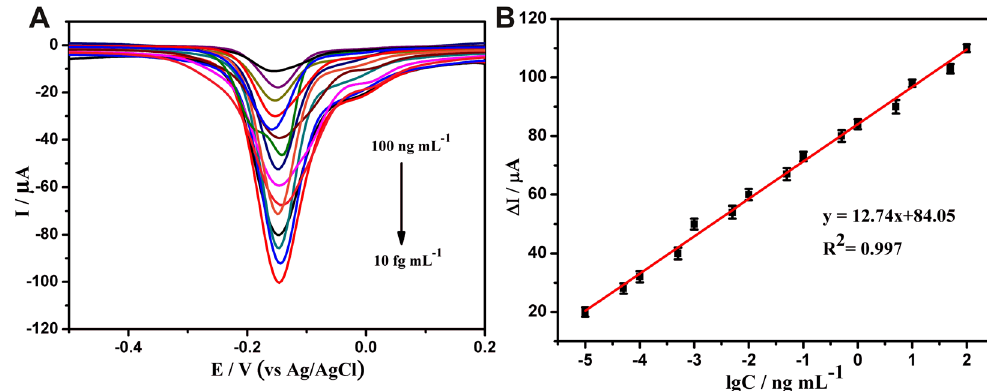
Figure 5. SWV responses of electrochemical immunoassay in 0.1 M PBS and 5 mM H 2 O 2 (pH 7.0), curves a–i correspond to CYFRA21-1 at the concentrations from 100 ng mL − 1 to 10 fg mL − 1 . ( B ) The calibration plot between the SWV peak current and the logarithm values of CYFRA21-1 concentrations. Error bars represent standard deviation, n =